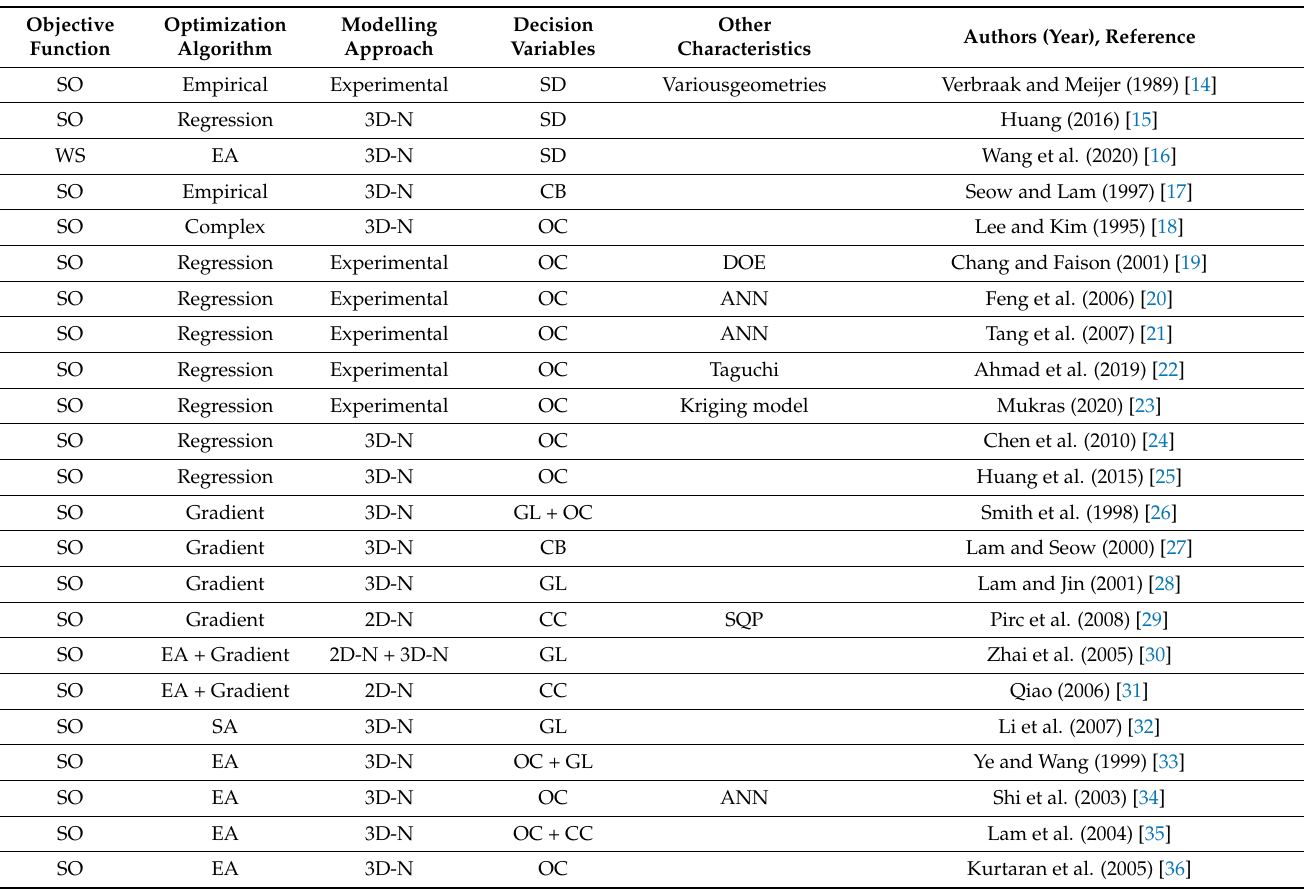
Table 2. Previous publications on the optimization of injection molding (SD—screw design, GL—gate location, OC—operating conditions, MD—mold design, CC—cooling channels, RS—runner system, CB—cavity balancing, PG—part